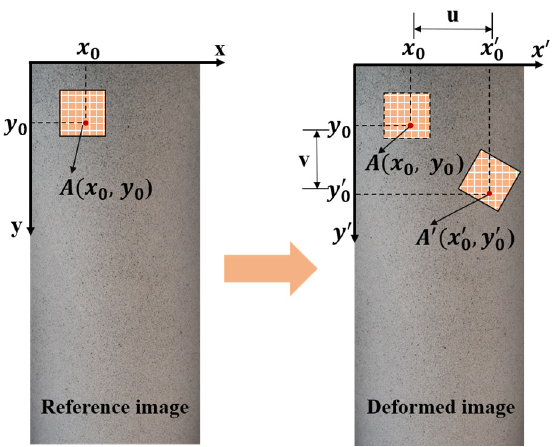
Figure 3. Schematic of the DSCM. Combined with the DSCM method, secondary uniaxial compression tests were per- formed on the pre-damaged granite to explore the damage evolution and failure laws. The observation surface of each specimen was uniformly sprayed with a layer of matte white paint, and they were then randomly sprayed with matte black paint. After air drying, a uniaxial compression rigidity testing machine was used for displacement loading at 0.02 mm/min, and a CCD camera was used for shooting until the specimen was destroyed. The experimental scheme is shown in Figure 4.